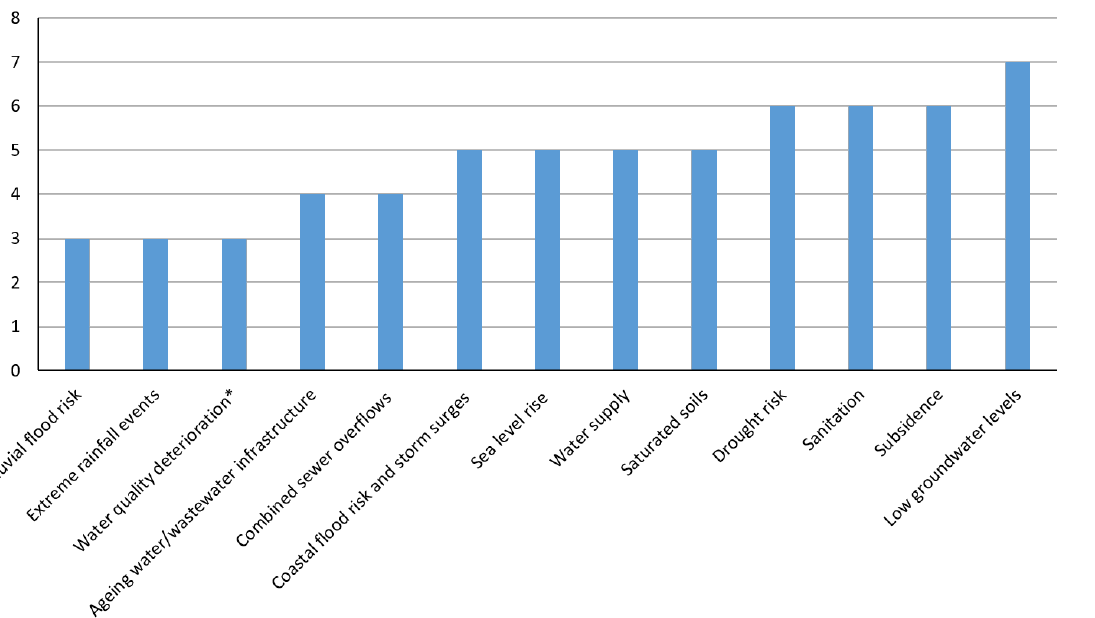
Figure 4. The level of agreement between respondents in each city regarding the perception that the benefits of BGI (Blue- Green Infrastructure) are very important or important. Values range from 0 (red, which indicate that no members of the city group found the benefit to be very important or important) to 100 (green, which indicate that all members of the city group found the benefits to be very important or important). RWH = Rainwater Harvesting.